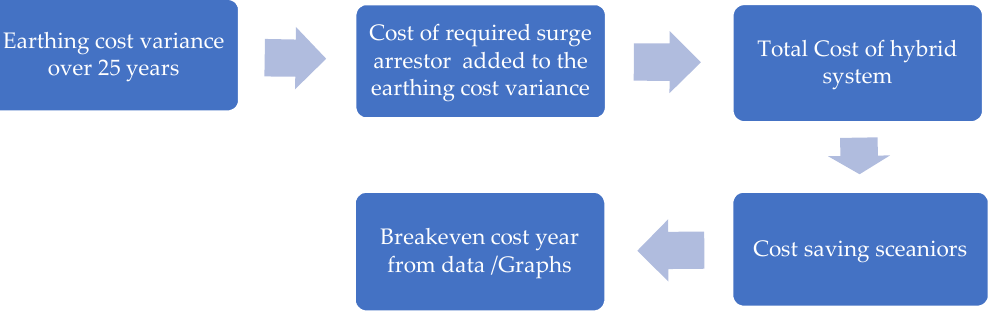
Figure 8. The process used to calculate the break-even cost of the hybrid system.